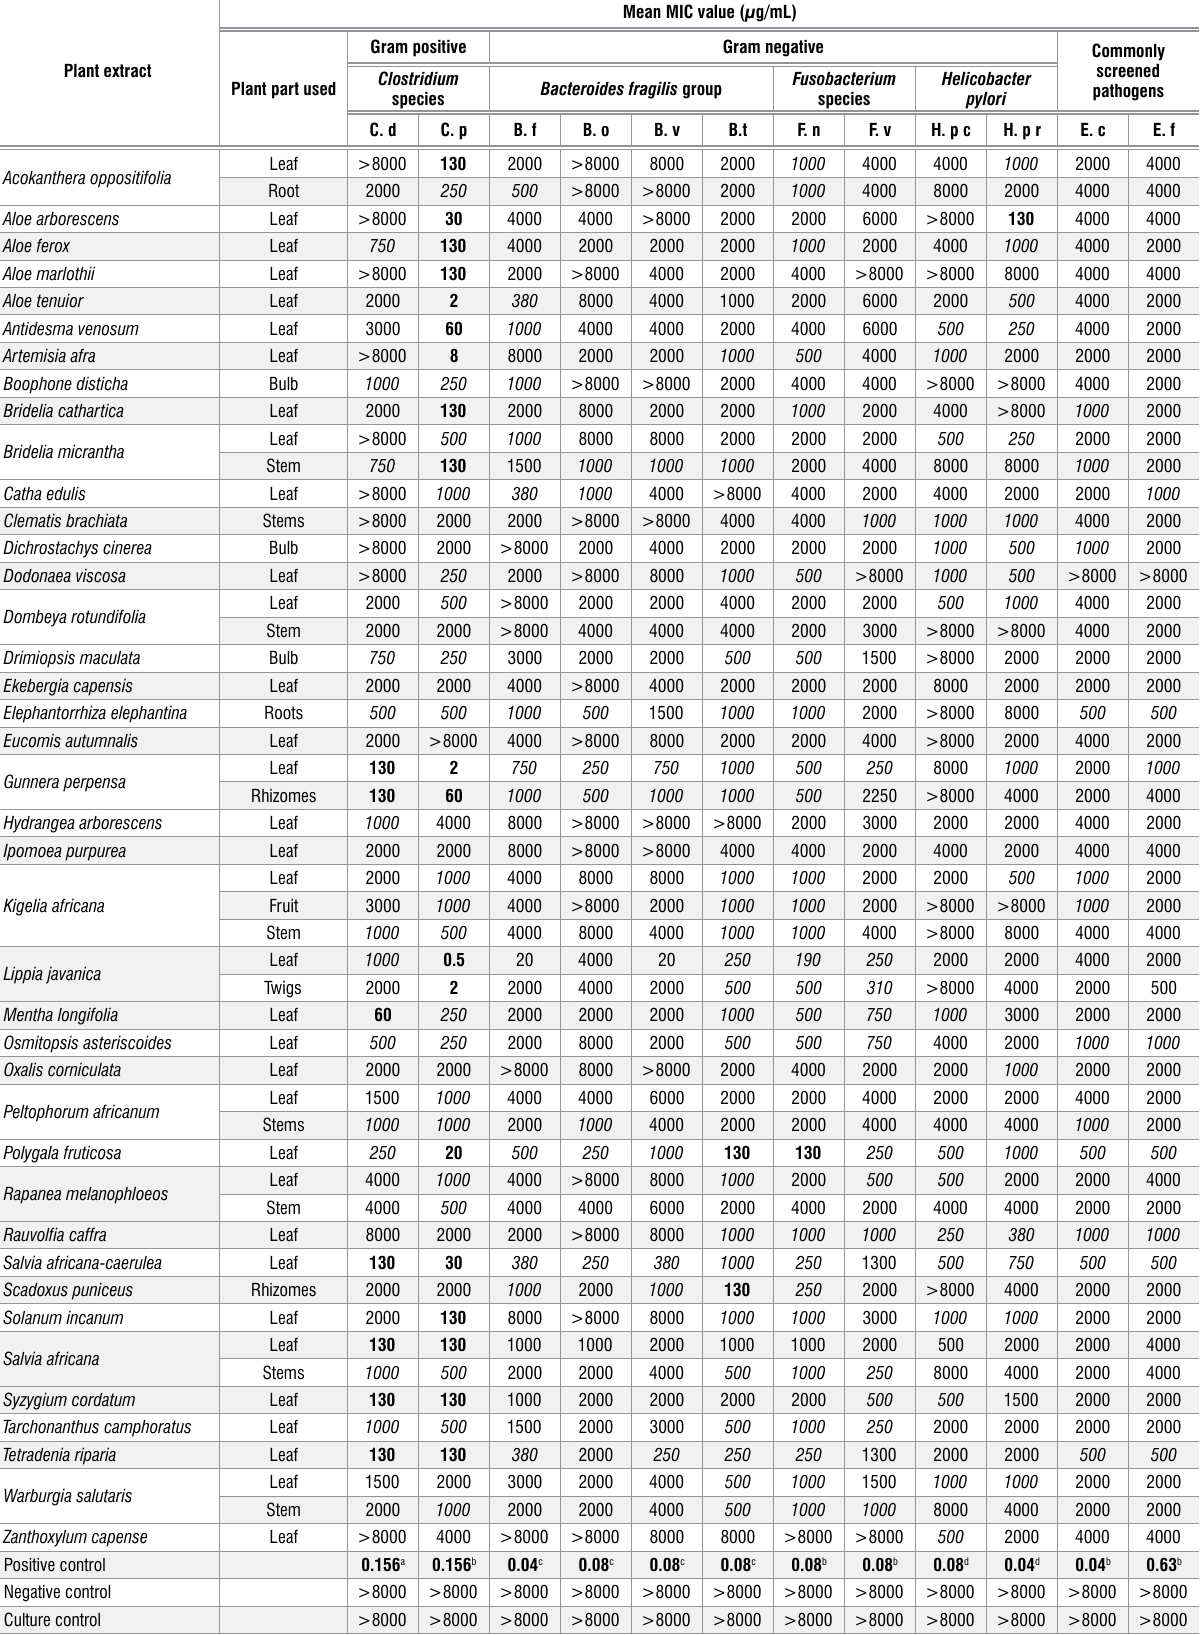
Table 3 : The antimicrobial (MIC values in μg/mL) efficacy of organic plants extracts against neglected and common pathogens of the gut